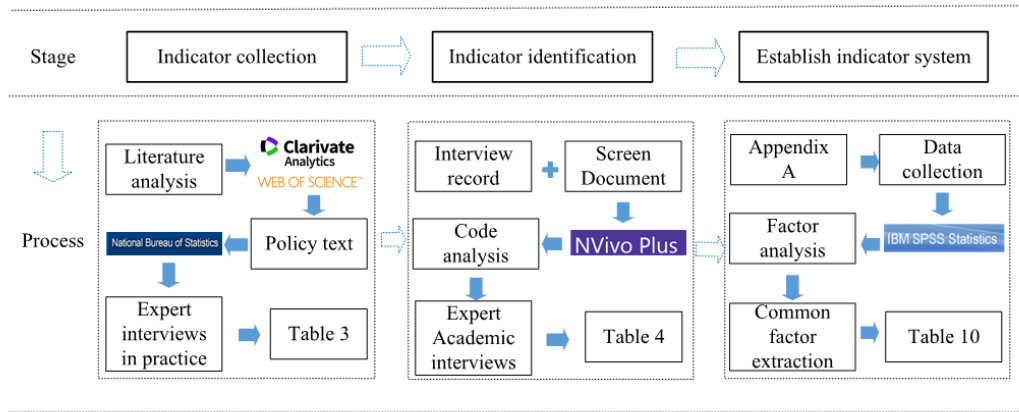
Figure 1. Research framework and